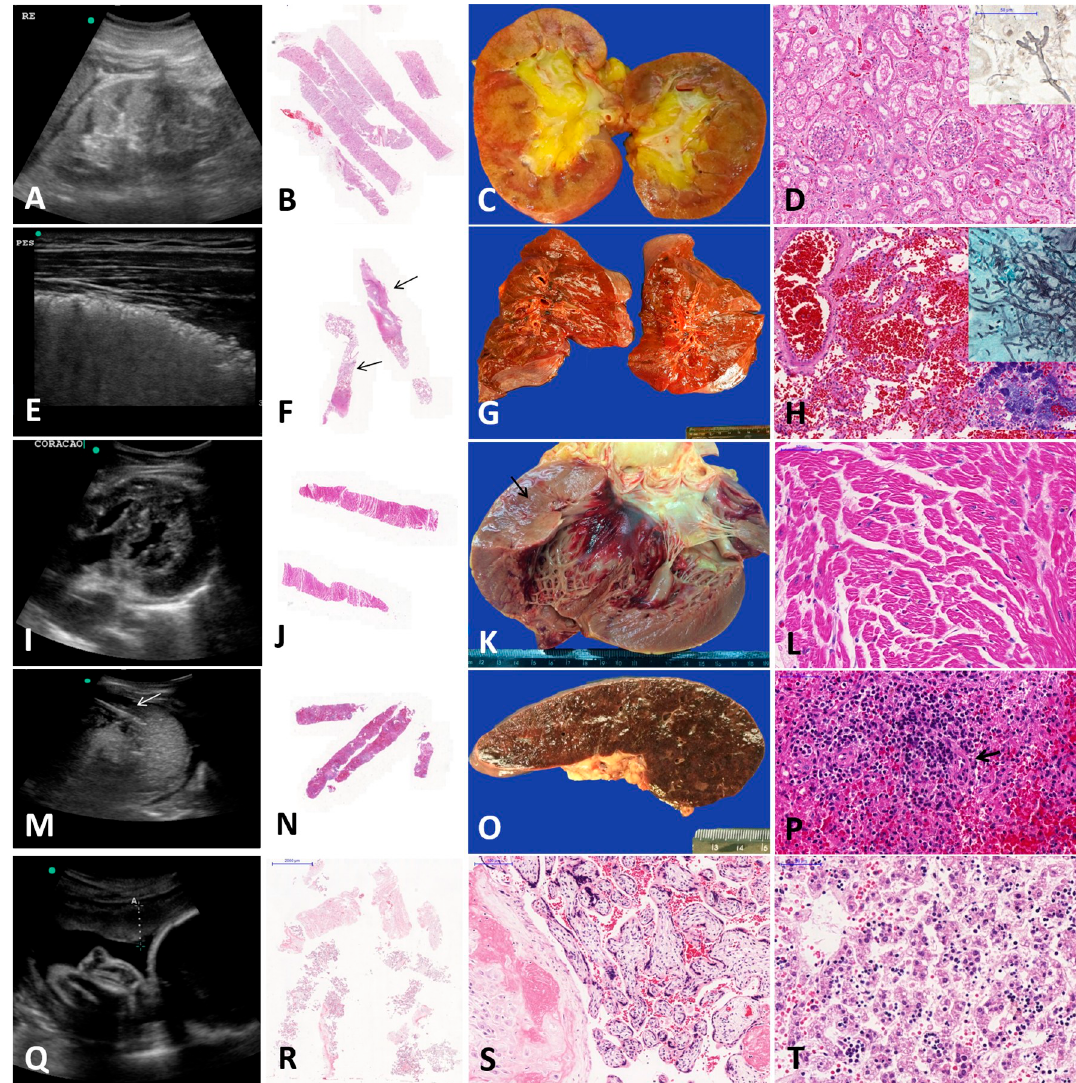
Fig 3. Post-mortem examination of fulminant yellow fever cases performed by ultrasound-guided minimally invasive autopsy (MIA-US) and conventional autopsy (CA). (A-D) Kidneys : nephromegaly detected by US (A); H&E slide, at low magnification, showing kidney samples collected by MIA-US (B); gross examination of kidneys showing edema and icterus (C); microscopy showing mesangial cell hyperplasia and acute tubular necrosis (D). The inset shows typical Aspergillus hyphae invading an interstitial arterial vessel in the renal parenchyma, diagnosed in the left kidney from one case, only in the MIA-US sample (reticulin stain). (E-H) Lungs : lung hepatization detected by US (E); H&E slide, at low magnification, showing lung samples collected by MIA-US with foci of pneumonia (arrows) (F); gross exam of lungs with red hepatization and edema (G); microscopy of lungs (H) showing alveolar hemorrhage (HE, left), invasive pulmonary aspergillosis (Grocott stain, right top) and pneumonia with colonies of Gram-positive cocci (H&E, right bottom). (I-L) Heart : a concentrically hypertrophic left ventricle detected by US (I); H&E slide, at low magnification, showing heart samples collected by MIA-US (J); gross exam of a heart exhibiting left ventricle hypertrophy (arrow) and subendocardial hemorrhages (K); microscopy showing hypertrophic cardiomyocytes and interstitial edema (L). (M–P) Spleen : an image of MIA-US at the moment of needle insertion in splenic mass (arrow) to collect post-mortem samples (M); H&E slide, at low magnification, showing spleen samples collected by MIA-US (N); gross exam of the spleen showing diffuse congestion on the cut surface (O); microscopy revealing splenitis, hemorrhage, and lymphoid hypoplasia (P). (Q-T) MIA-Us of a pregnant woman : the US image shows the uterus, placenta, amniotic fluid and fetus (Q); H&E slide, at low magnification, showing the placental samples collected by MIA-US (R); histology of placenta with maternal decidua and villi (S); the fetal liver sampled by MIA-US showing ischemic damage and extramedullary hematopoiesis